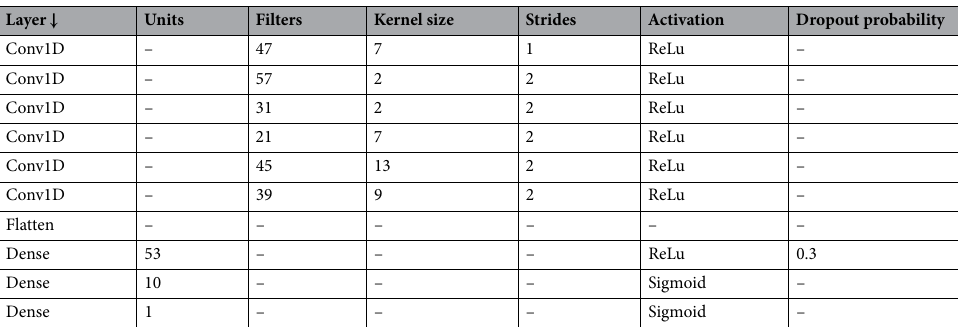
Table 1. Architecture of LearNet. The structure is intended to be sequentially ordered from top to bottom and divided into two parts: the first is composed of 1D convolutional layers and is intended as a feature extractor. The second is composed of dense layers and has the role of the classifier. We introduced a dropout between the first and the second dense layer to prevent